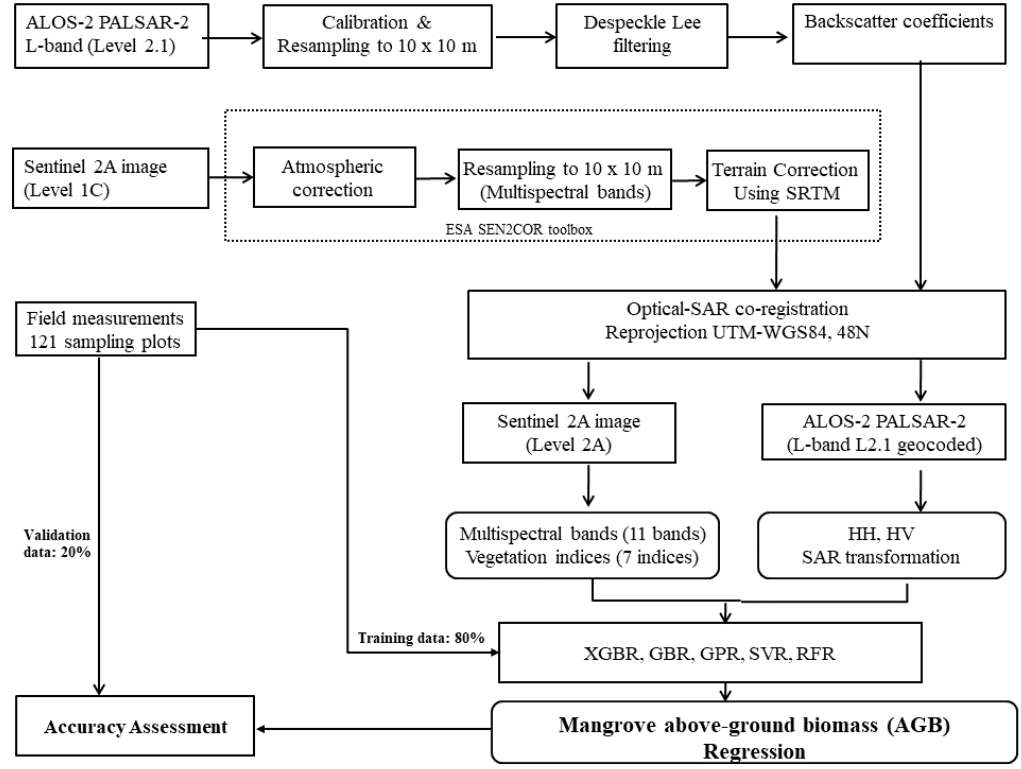
Figure 3. Flowchart for satellite-image processing and the generation of AGB models based on ML techniques.